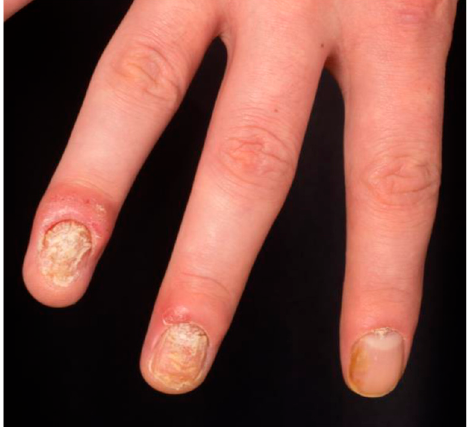
Figure 3. Onycholysis and oil drop changes on psoriatic nail involvement.